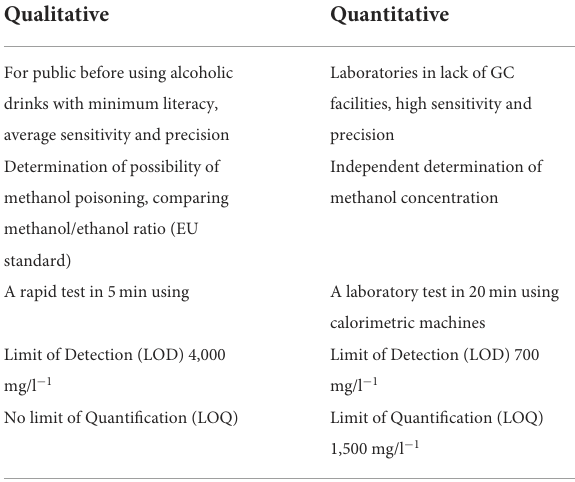
TABLE 3 Qualitative and quantitative advantages/disadvantages of CA